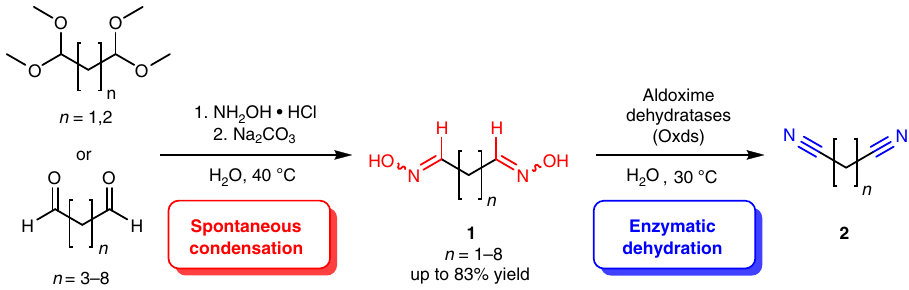
Fig. 2 Sustainable chemoenzymatic approach towards α , ω -dinitriles starting from α , ω -dialdehydes or their bis-dimethyl acetals. Eight different α , ω - dialdoximes have been synthesized and investigated as substrates for the enzymatic dehydration